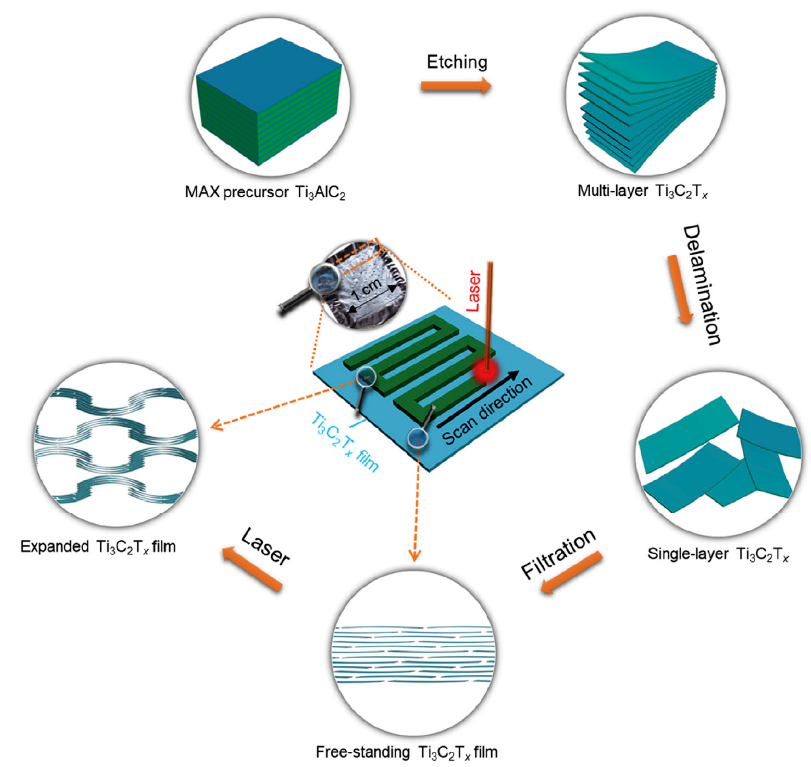
Figure 15. Schematic diagram of 3D porous MXene film synthesis using laser engraving; reproduced from [61], with the permission of Elsevier.